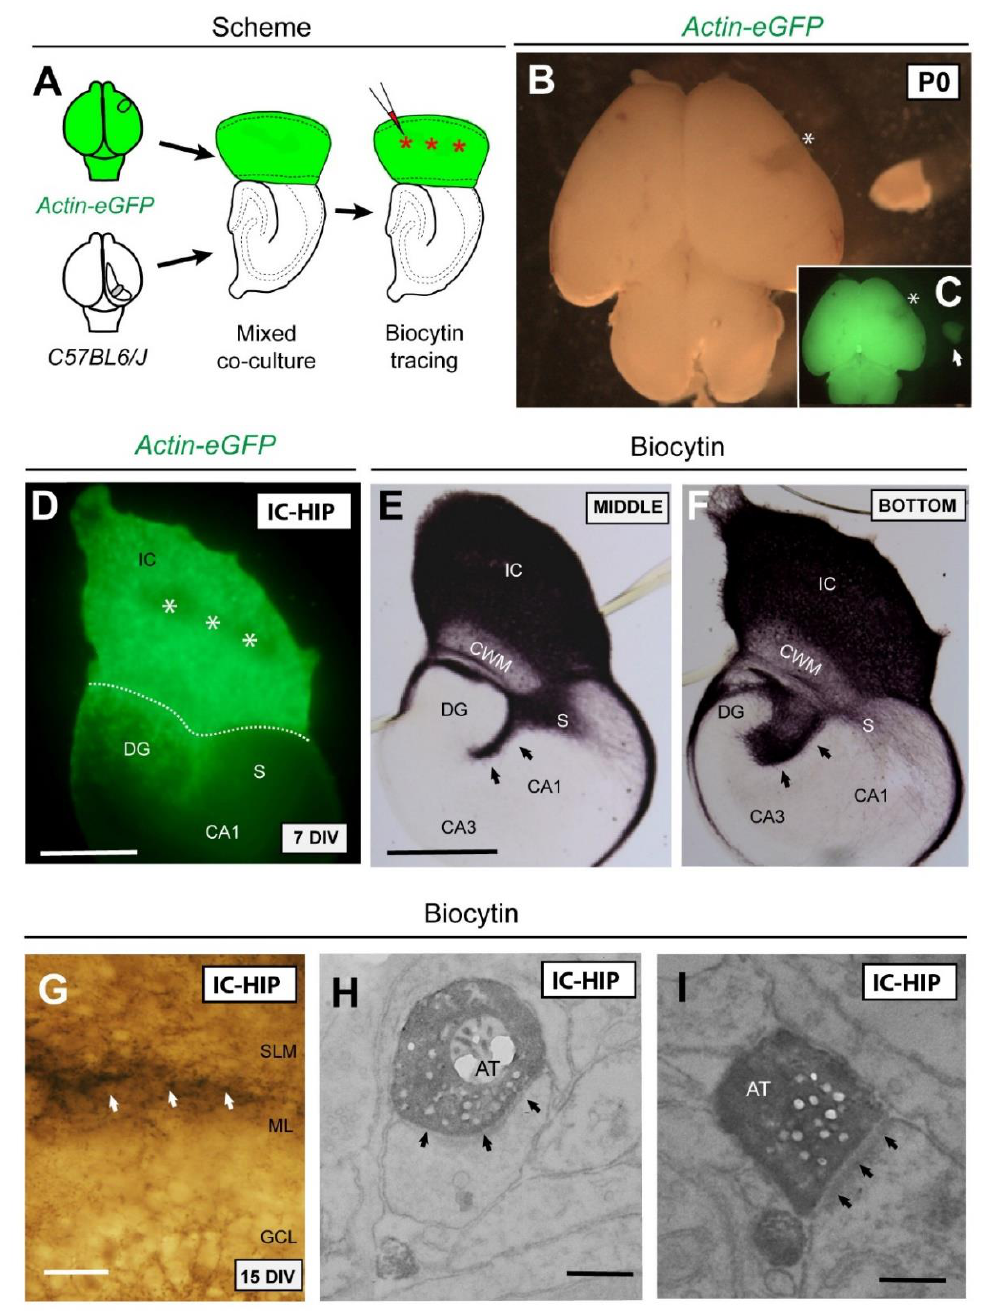
Figure 3. Schematic diagram illustrating the experimental design. ( A ) A small piece of the isocortex (parietal cortex) from Actin-eGFP mice at P0 was transplanted in replacement of the original entorhinal cortex of C57BL6/J in order to perform a mixed iso-hippocampal co-culture. After 6 DIV, biocytin tracer was injected in the isocortical region (asterisks). ( B , C ) Bright-field and fluorescence micrographs of Actin-eGFP brain showing the dissected area (asterisk). ( D ) After 7DIV, eGFP-positive isocortical axons were seen crossing the subiculum and entering the hippocampus. Dashed line indicates the boundary between the isocortex and hippocampus. ( E , F ) Sections from the middle and the bottom of the organotypic co-culture illustrating biocytin-labeled axons from the isocortical region. ( G ) A high-magnification of biocytin-labeled axons (arrows) innervating the SLM/ML boundary. ( H , I ) Electron micrographs showing asymmetric contacts (arrows) established between isocortical axons and apical dendrites of granular neurons. Abbreviations as in Figures 1 and 2 and AT = axonal terminal; CWM = cortical white matter. Scale bars: D = 250 µ m; E = 250 µ m pertains to (F); G = 50 µ m; H = 1 µ m pertains to